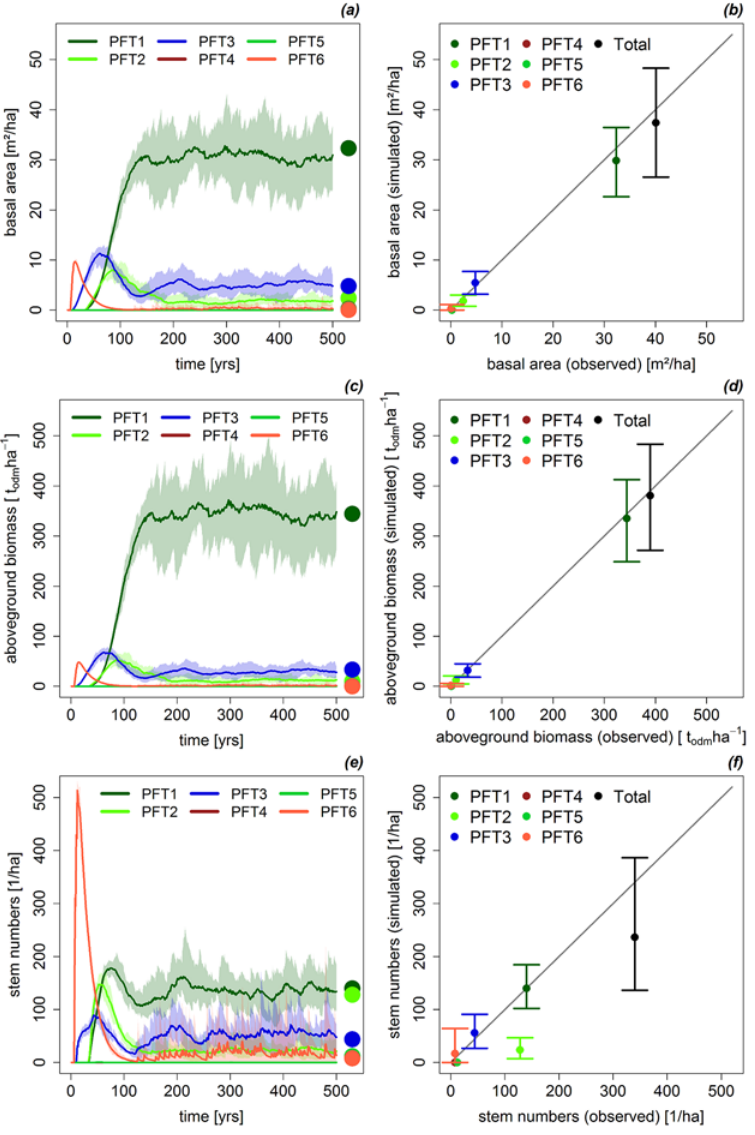
Fig 2. Simulation vs. Measurements. Comparison between simulated variables and measurements from the forest inventory at Mt. Kilimanjaro. Presented are simulated basal area (a), aboveground biomass (c), and stem numbers (e) over time for each PFT. The points represent the measured value from the inventory data. A direct comparison between mean values of the simulation (300 – 1000 years) versus measured values for each PFT is also presented. The vertical lines represent the variation of the simulated value for basal area (b), aboveground biomass (d), and stem numbers